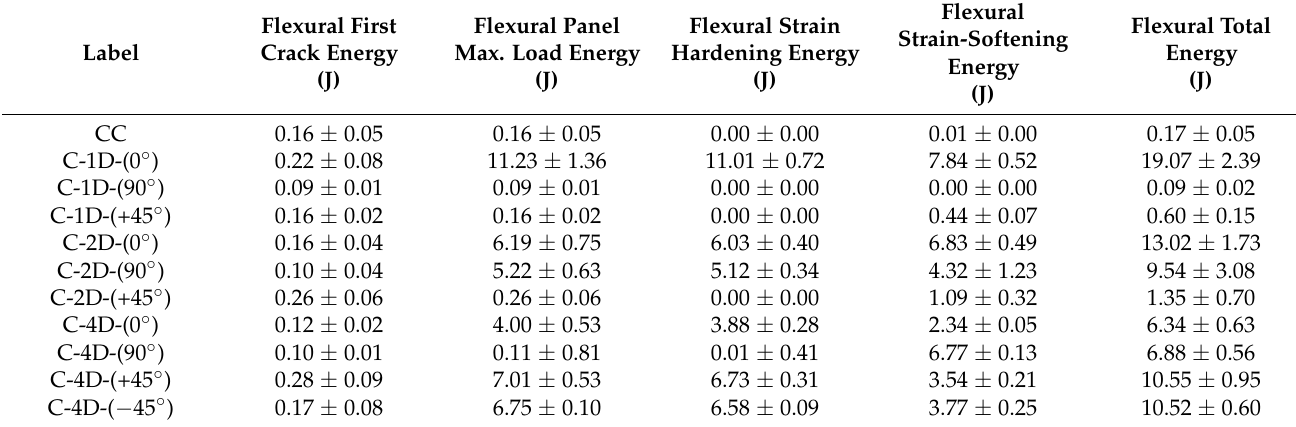
Figure 15. Off-axis flexural energy, first crack energy, and strain hardening energy of multiaxis 3D carbon fiber concrete. Table 5. Average off-axis flexural energy results for the multiaxis 3D carbon fiber concrete composites.